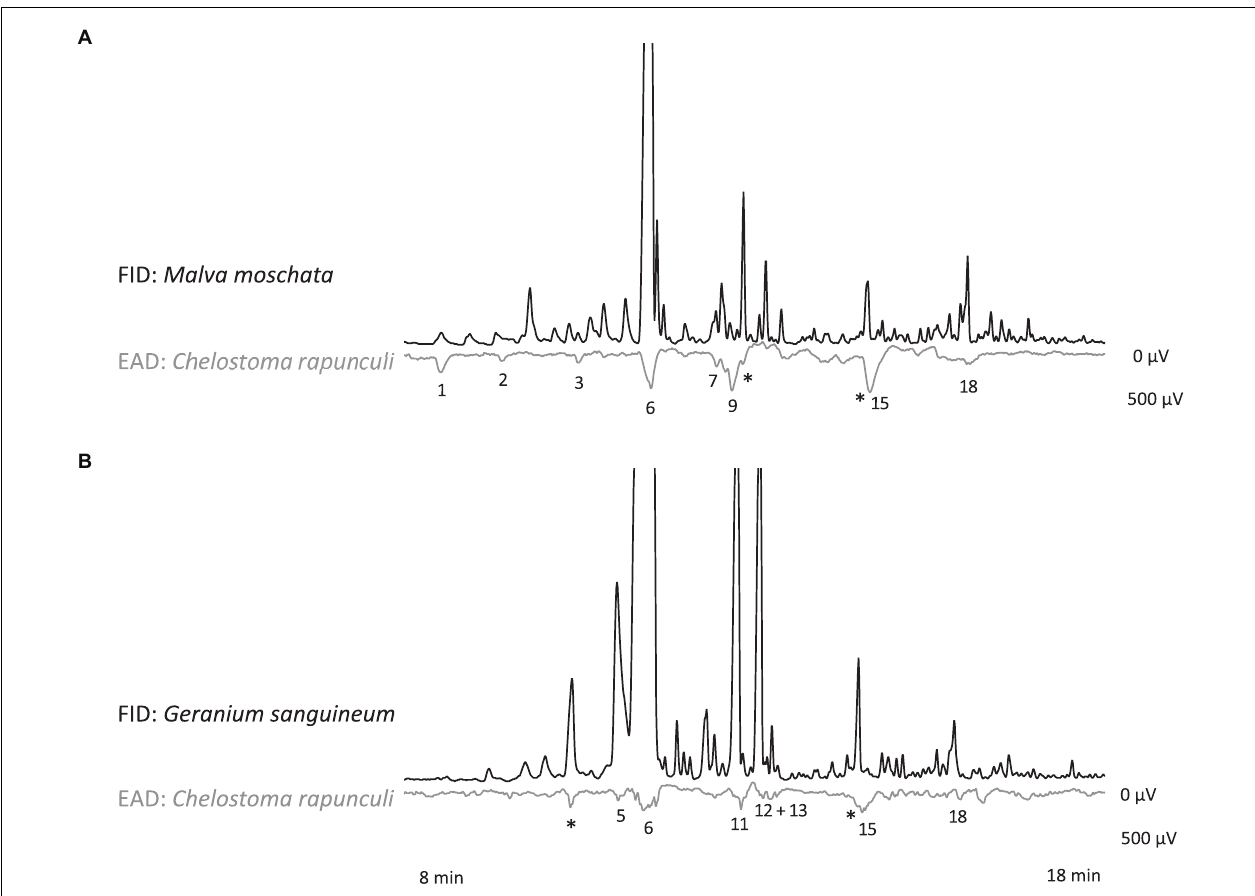
FIGURE 4 | Simultaneous recordings of gas chromatographic (FID) and electroantennographic (EAD) signals for antennae of C. rapunculi females and a headspace sample of (A) M. moschata and (B) G. sanguineum inflorescences. Responses of the shown individuals are labeled with numbers that correspond to numbers given in Table 1 . Responses to components of control samples are indicated by an